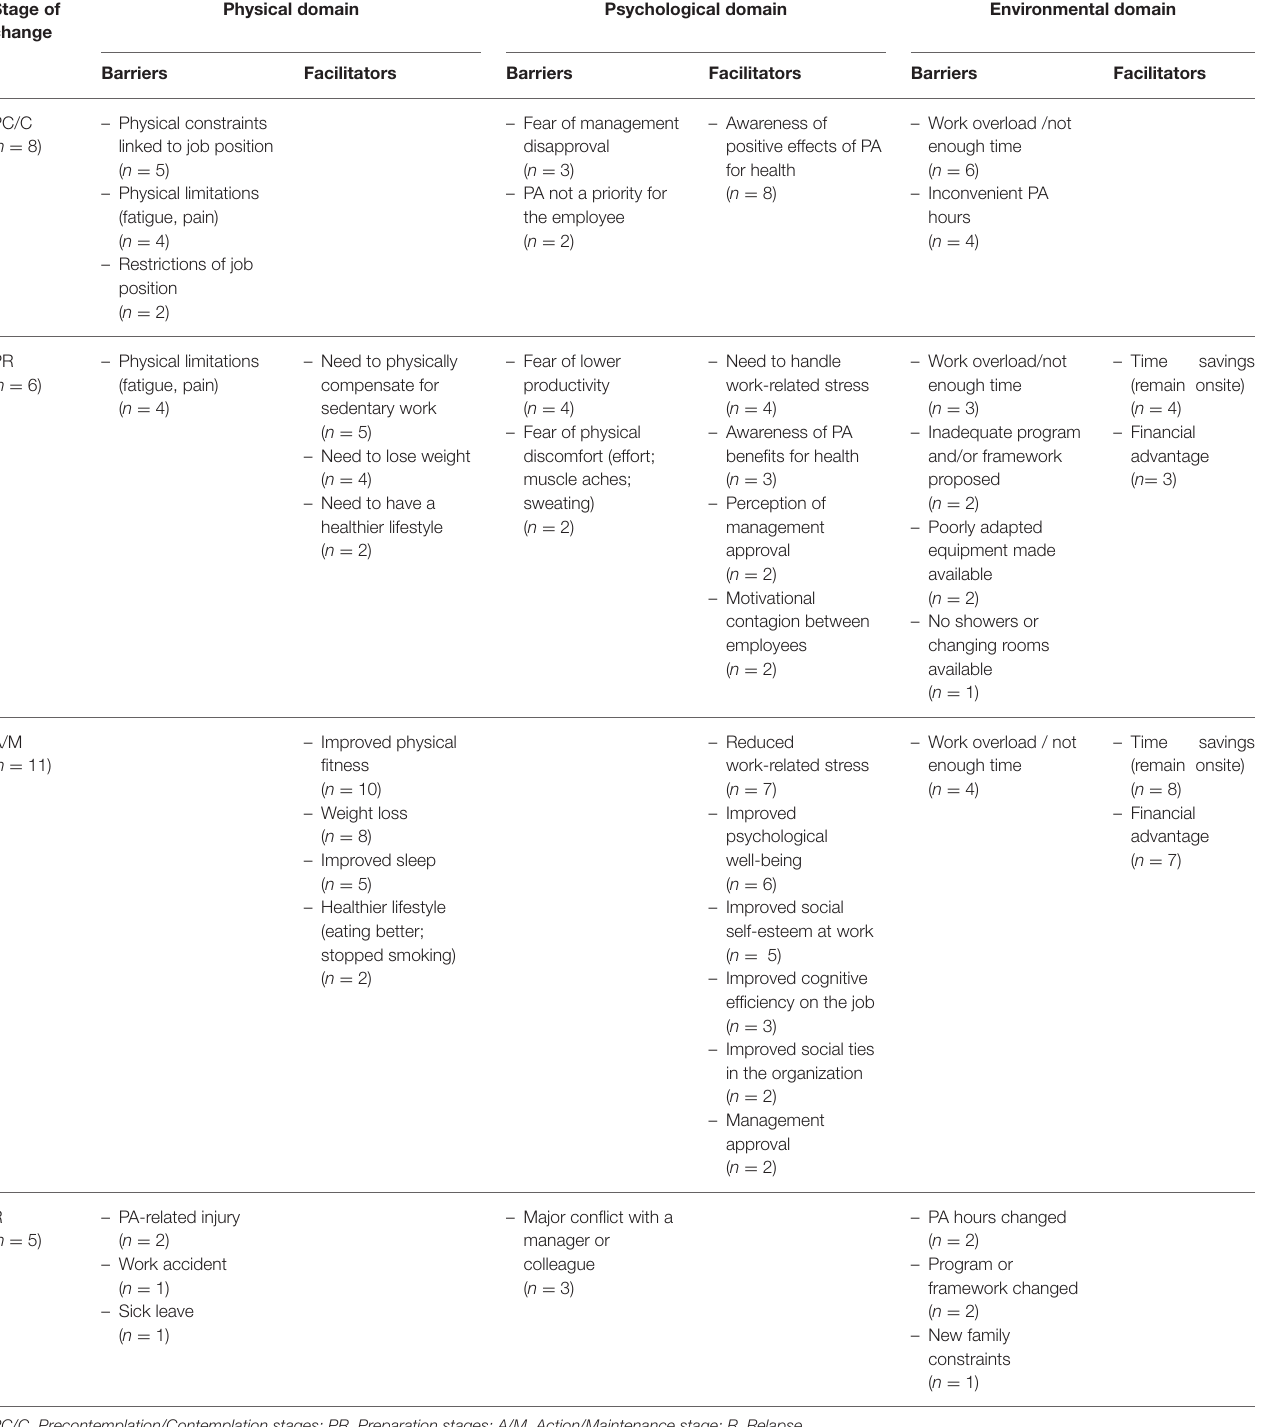
TABLE 3 | Worksite physical activity barriers and facilitators according to the participants’ stage of